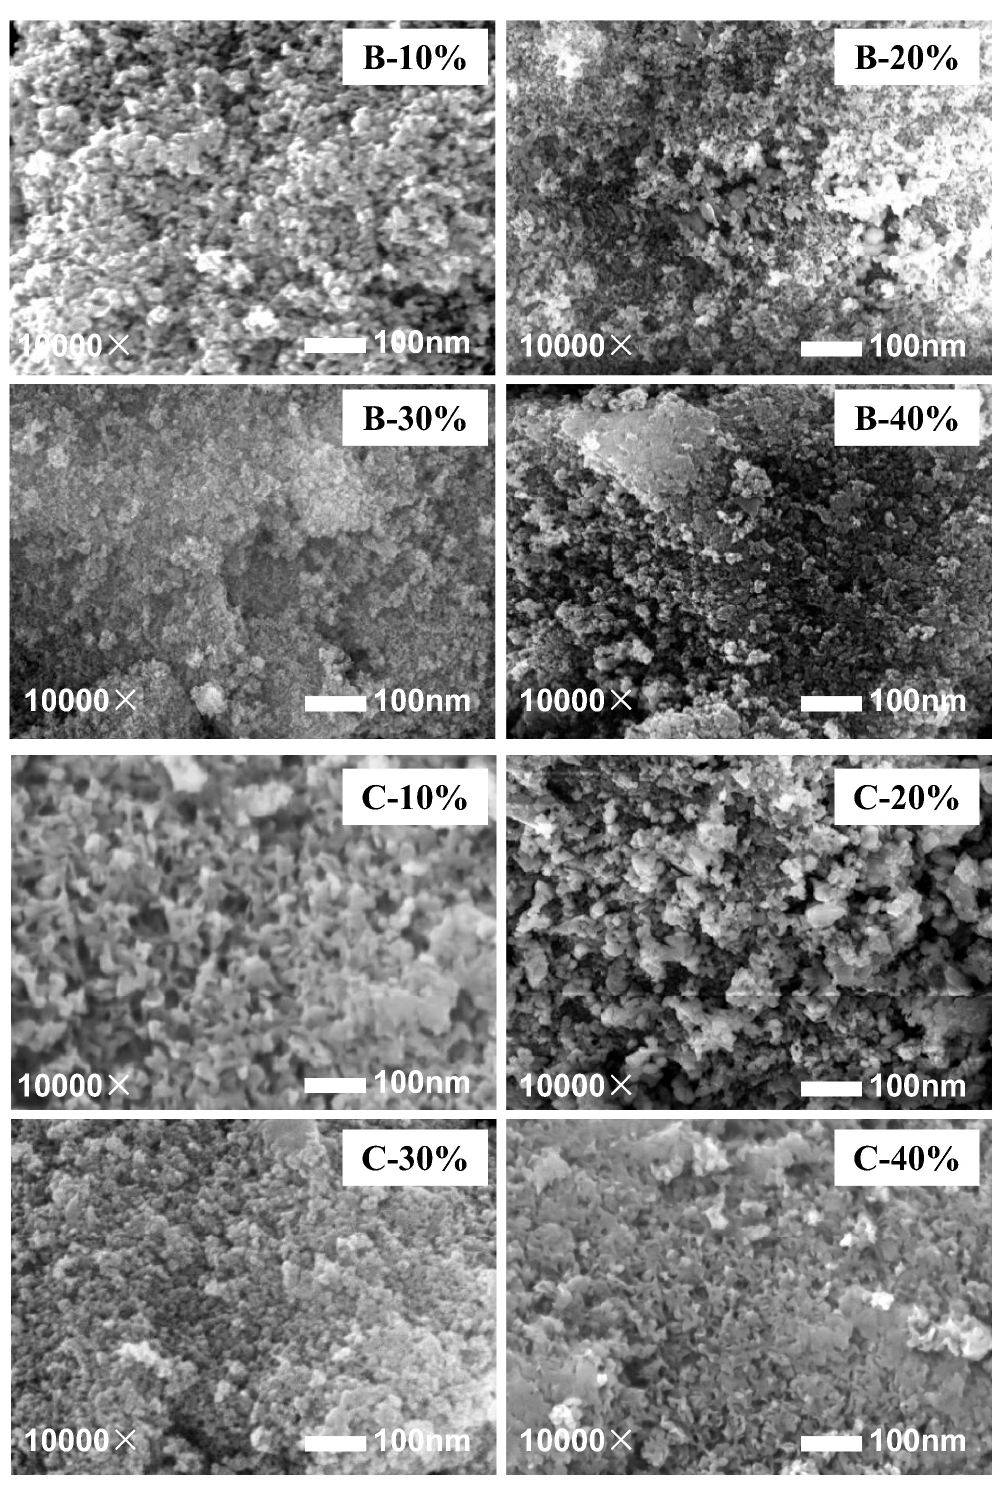
Figure 5. Microstructures of three types of Al aerogels under different loadings. ( A ) Al-B, ( B ) Al/Si, ( C ) Al/Si-TMCS.